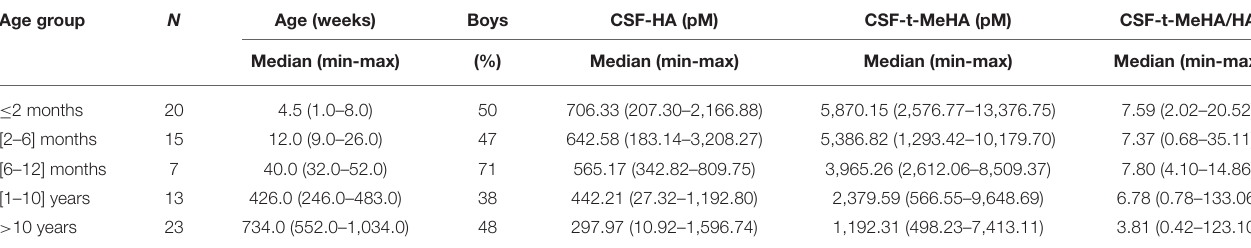
TABLE 1 | Population characteristics and CSF measures by age